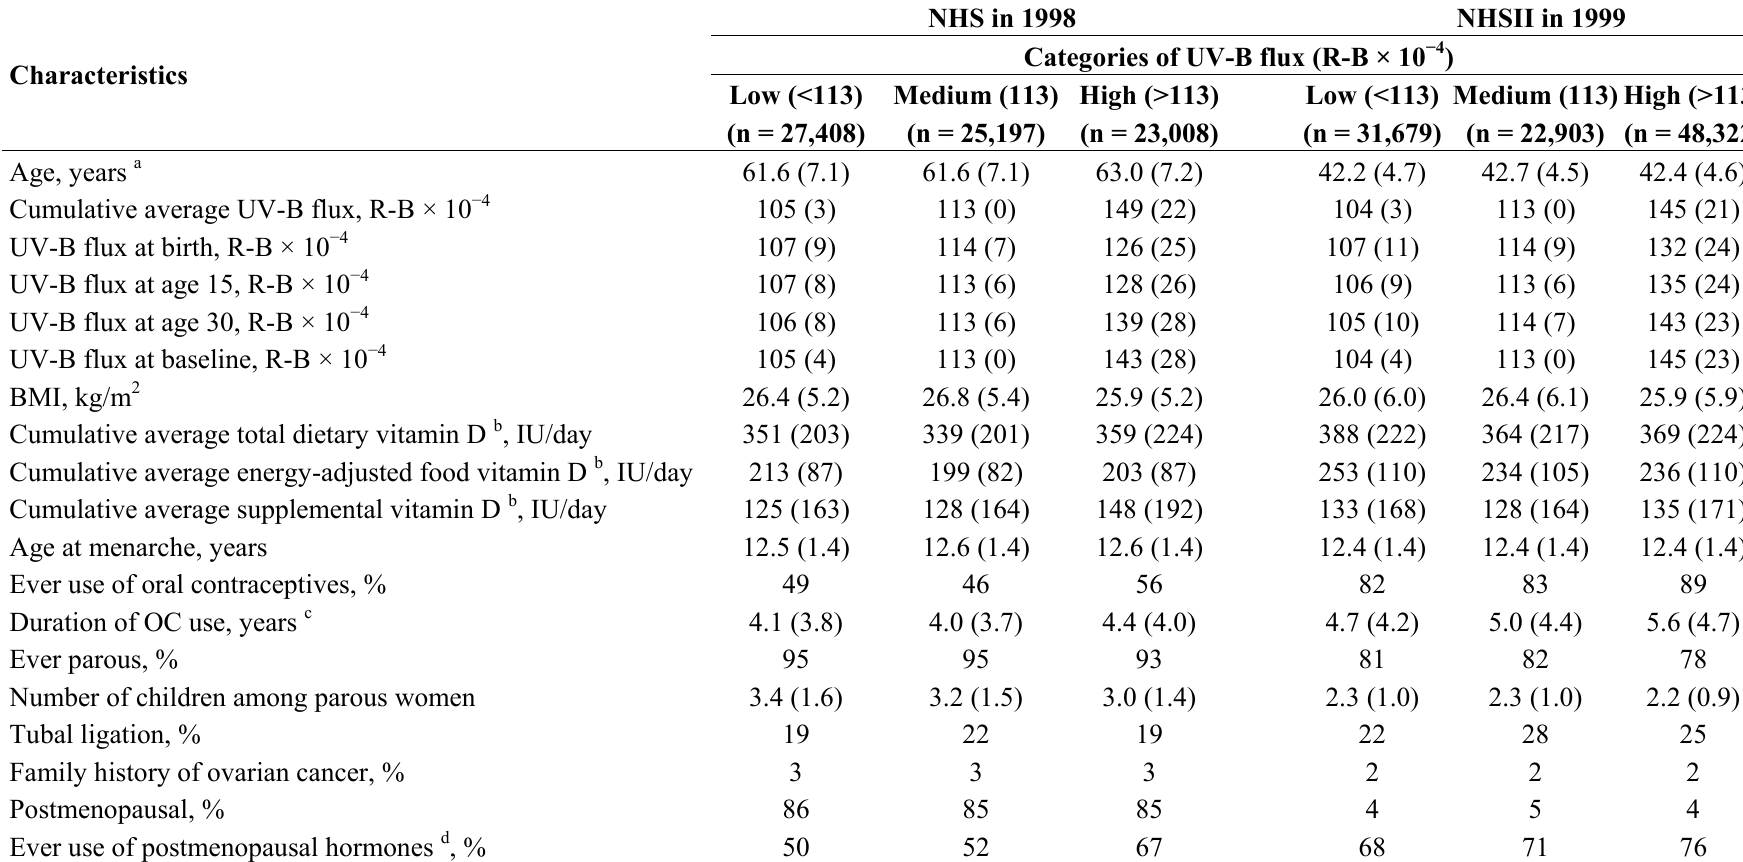
Table 1. Age-standardized characteristics of NHS and NHSII participants by category of UV-B flux at the midpoint of follow-up.